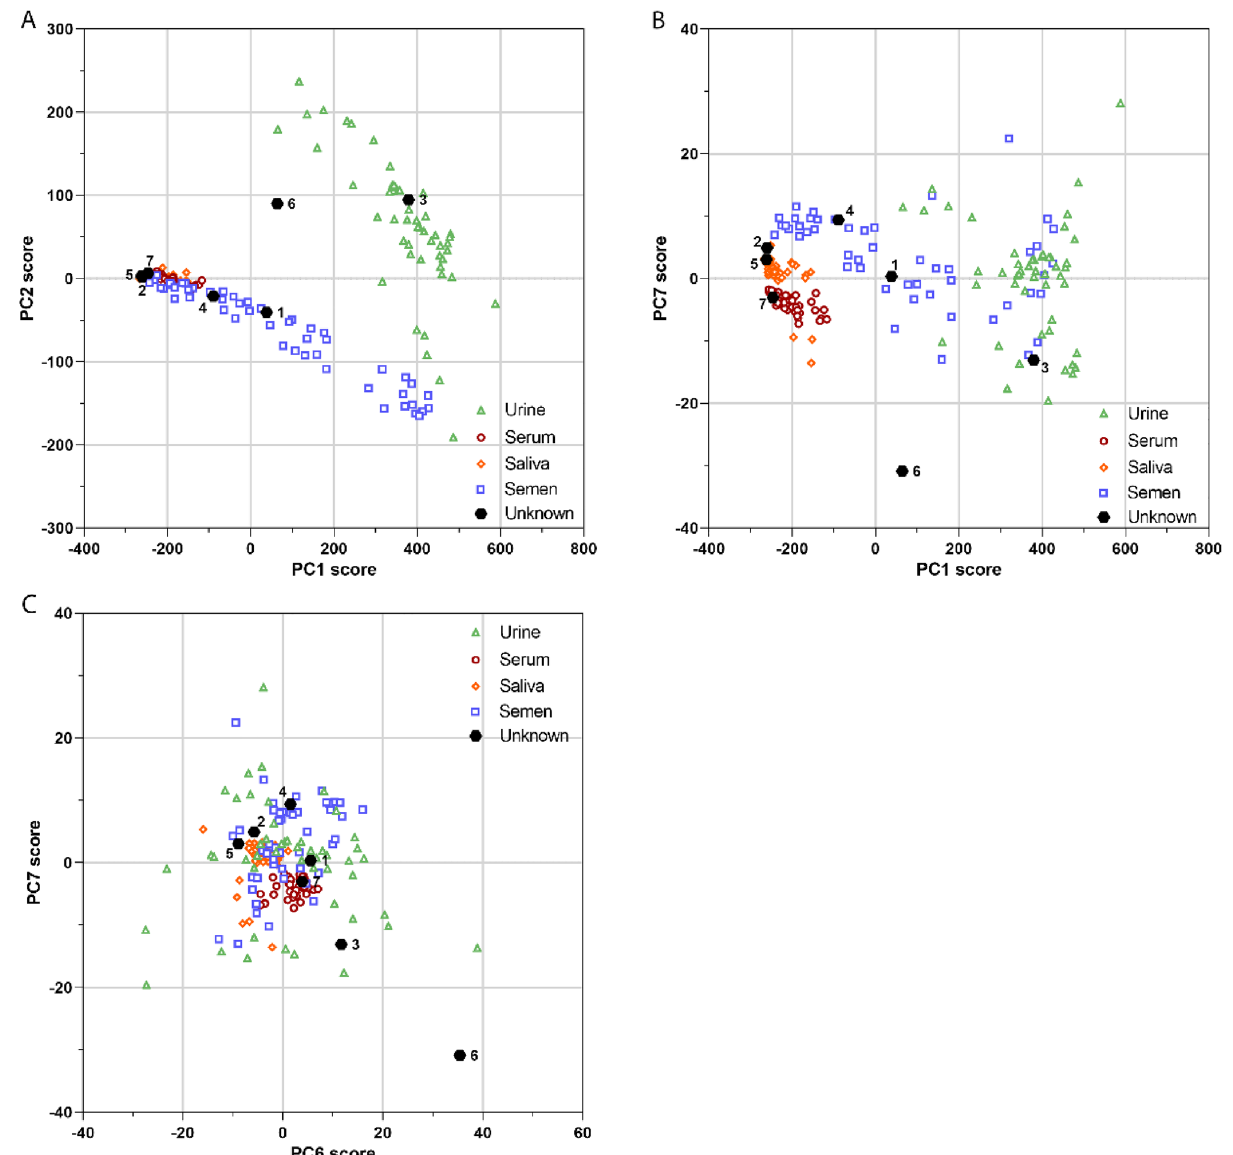
Figure 4. Body fluid classification using PCA. Biplots showing the scores of each sample of the principal components, including the unknown body fluid samples (n = 7, depicted as black hexagons). Each sample is plotted against the defined set of principal components, namely PC1 and PC2 ( A ), PC1 and PC7 ( B ) and PC6 and PC7 ( C ). The color and shape are depicted in the legend to represent the different body fluid